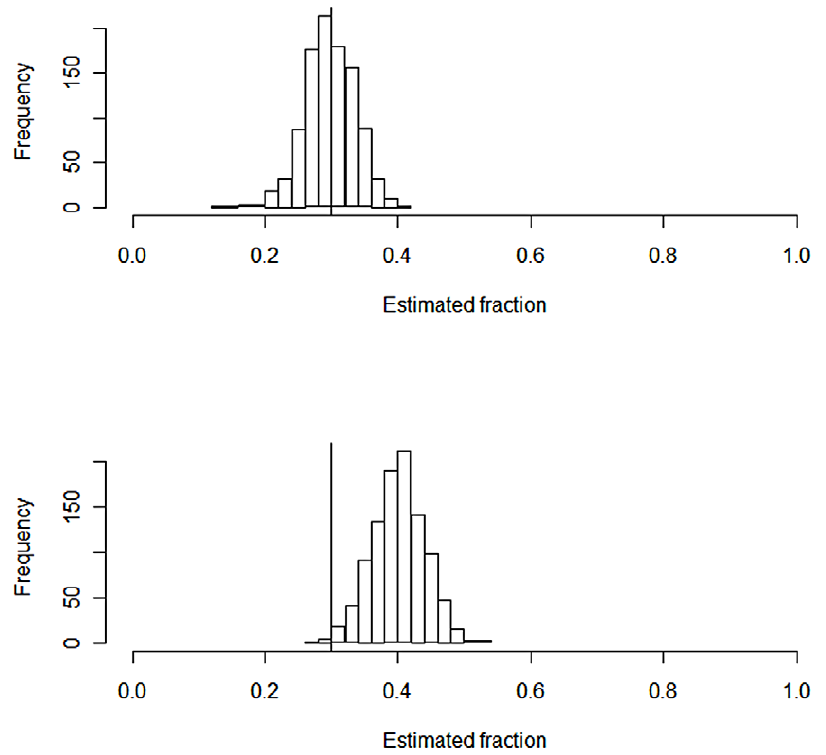
Figure 1. The upper panel shows that the proportion from contributor 1 is a reasonable estimate based on the correct model, whereas a clear bias appears for the wrong model. A total of 1000 simulations were performed.